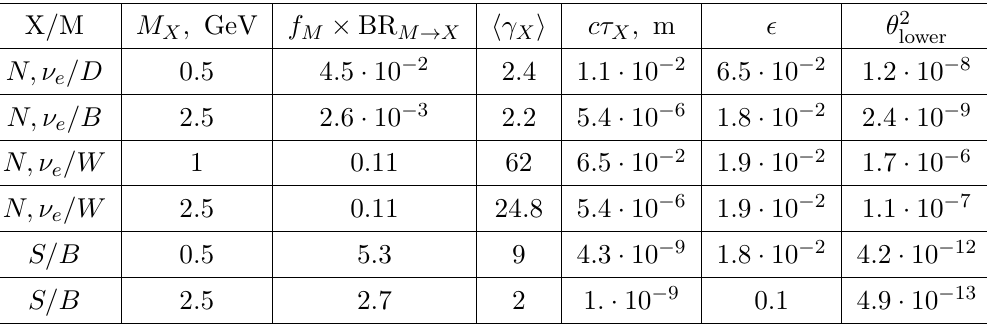
Table 6 . Table of parameters used in simple analytic estimation (2.1) for the MATHUSLA ex- periment for particular masses of the HNLs and scalars. We use the description of the scalar phenomenology from [19]. The columns are as follows: the type of the particle X and the mother particle, the branching ratio of the production of X at (cid:18) 2 = 1, average (cid:13) factor, proper decay X length c(cid:28) X at (cid:18) 2 = 1, overall e(cid:14)ciency (6.1), the mixing angle at the lower bound estimated as X N = 4, where N is given by events ; lower events ; lower